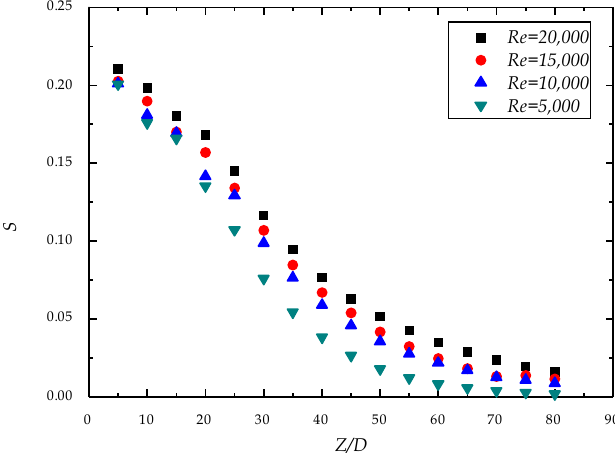
Figure 8. Variation in the swirl number at various positions under different Reynolds numbers ( α 0 = 2%, Y = 6.2).